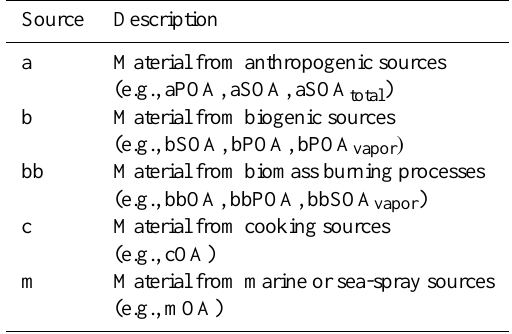
Table 3. Examples of emission source designations for OA classifi-